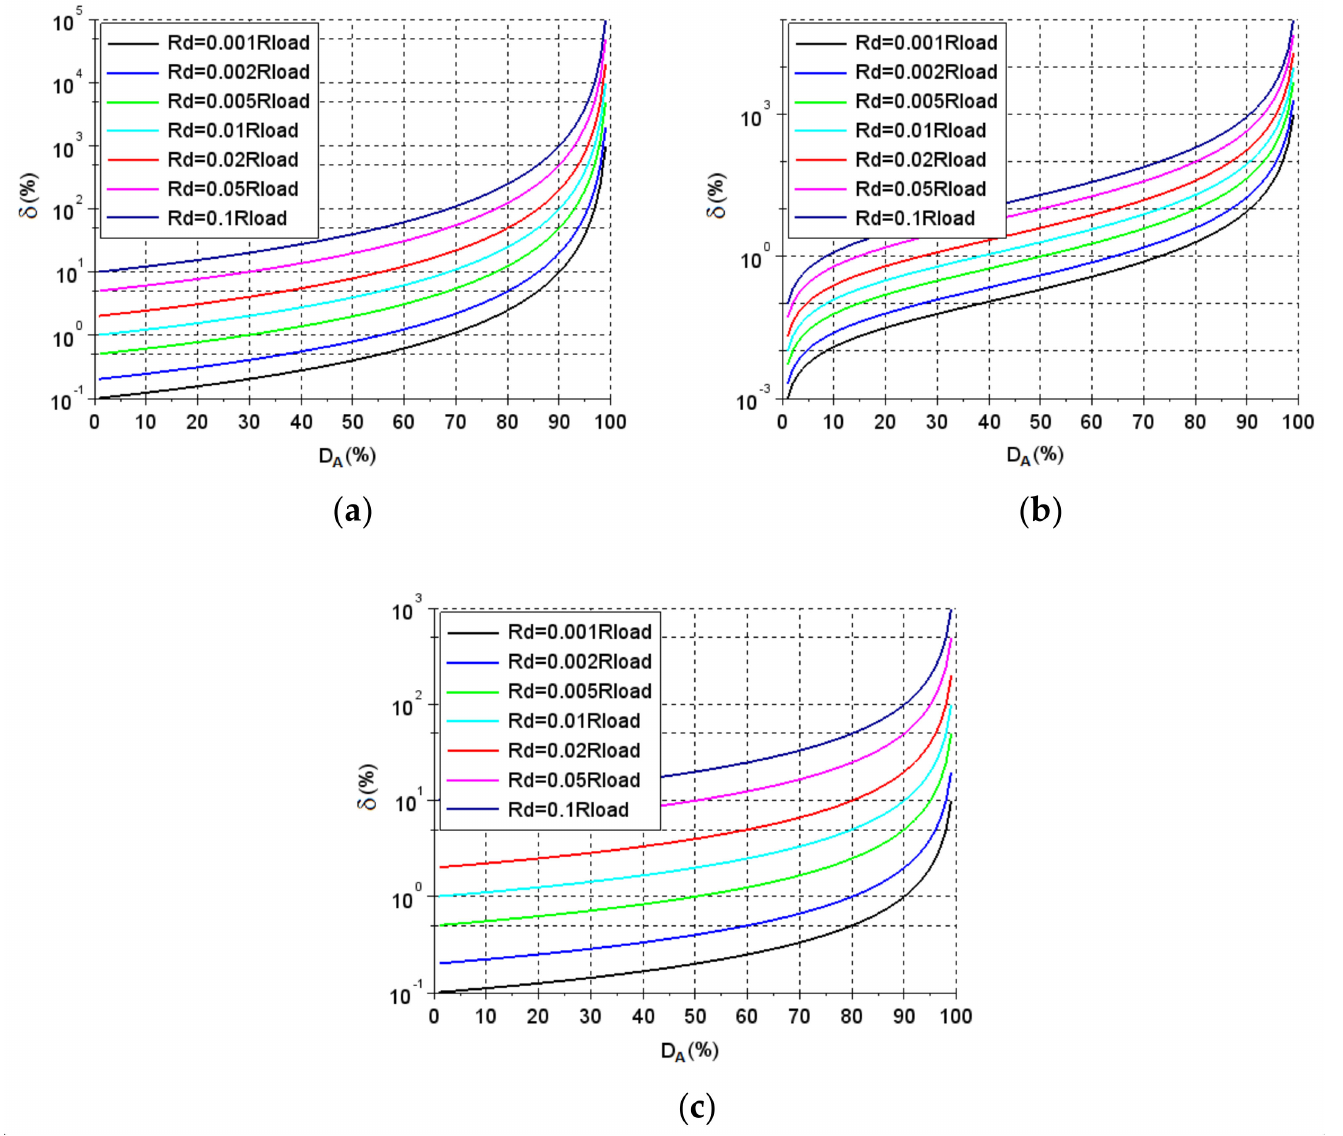
Figure A2. Influence of a specific parasitic resistance on the input resistance of a boost converter, for different duty cycle values. The figures represent a percentage error calculated with Equation (A1) for different values of: ( a ) inductor resistance R L ; ( b ) transistor resistance R T ; ( c ) diode resistance R D